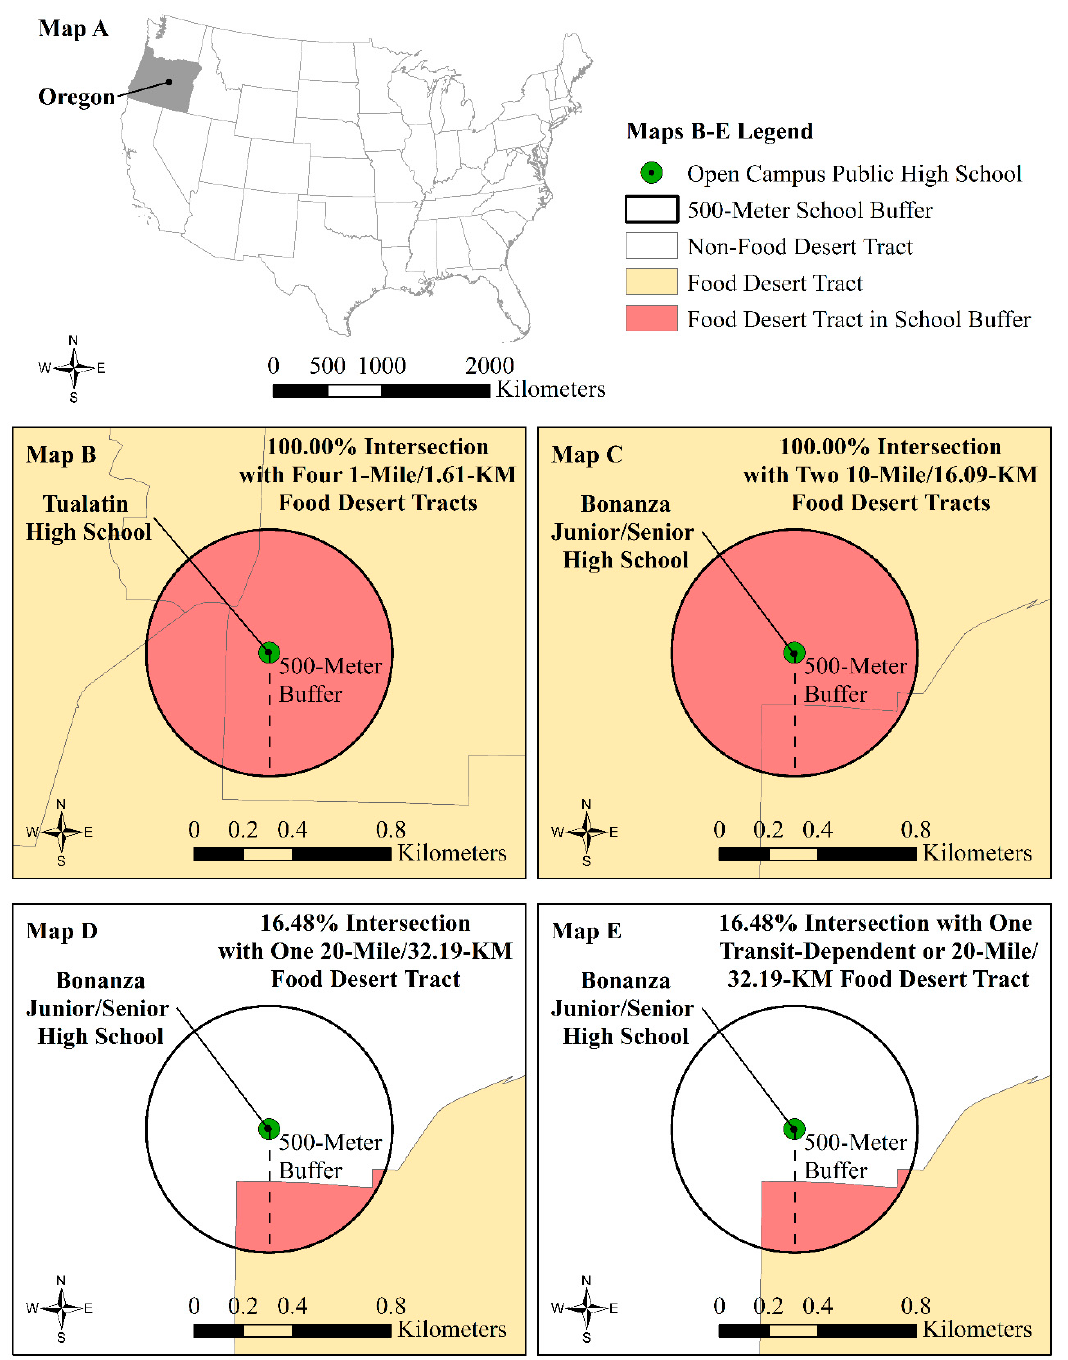
Figure 1. ( A ) Oregon and continental United States boundaries; ( B – E ) illustration of food desert tract intersection with a 500-m buffer for Oregon public schools to derive Oregon public high schools’ four food environment (food desert exposure) variables.